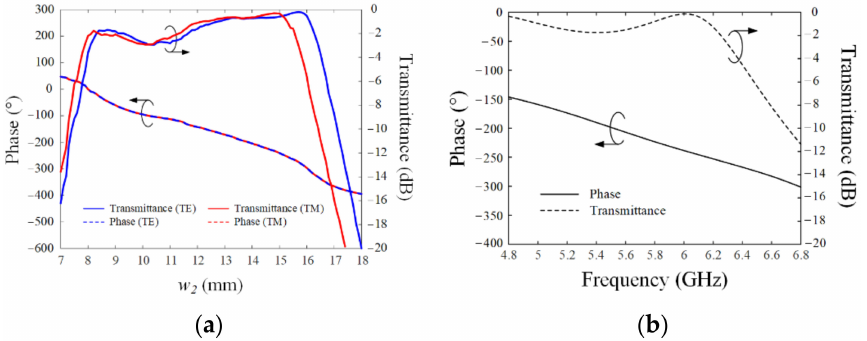
Figure 4. Transmittance and phase characteristics of the unit cell: ( a ) transmittance and phase characteristics according to for w 1 ; and ( b ) transmittance and phase characteristics by